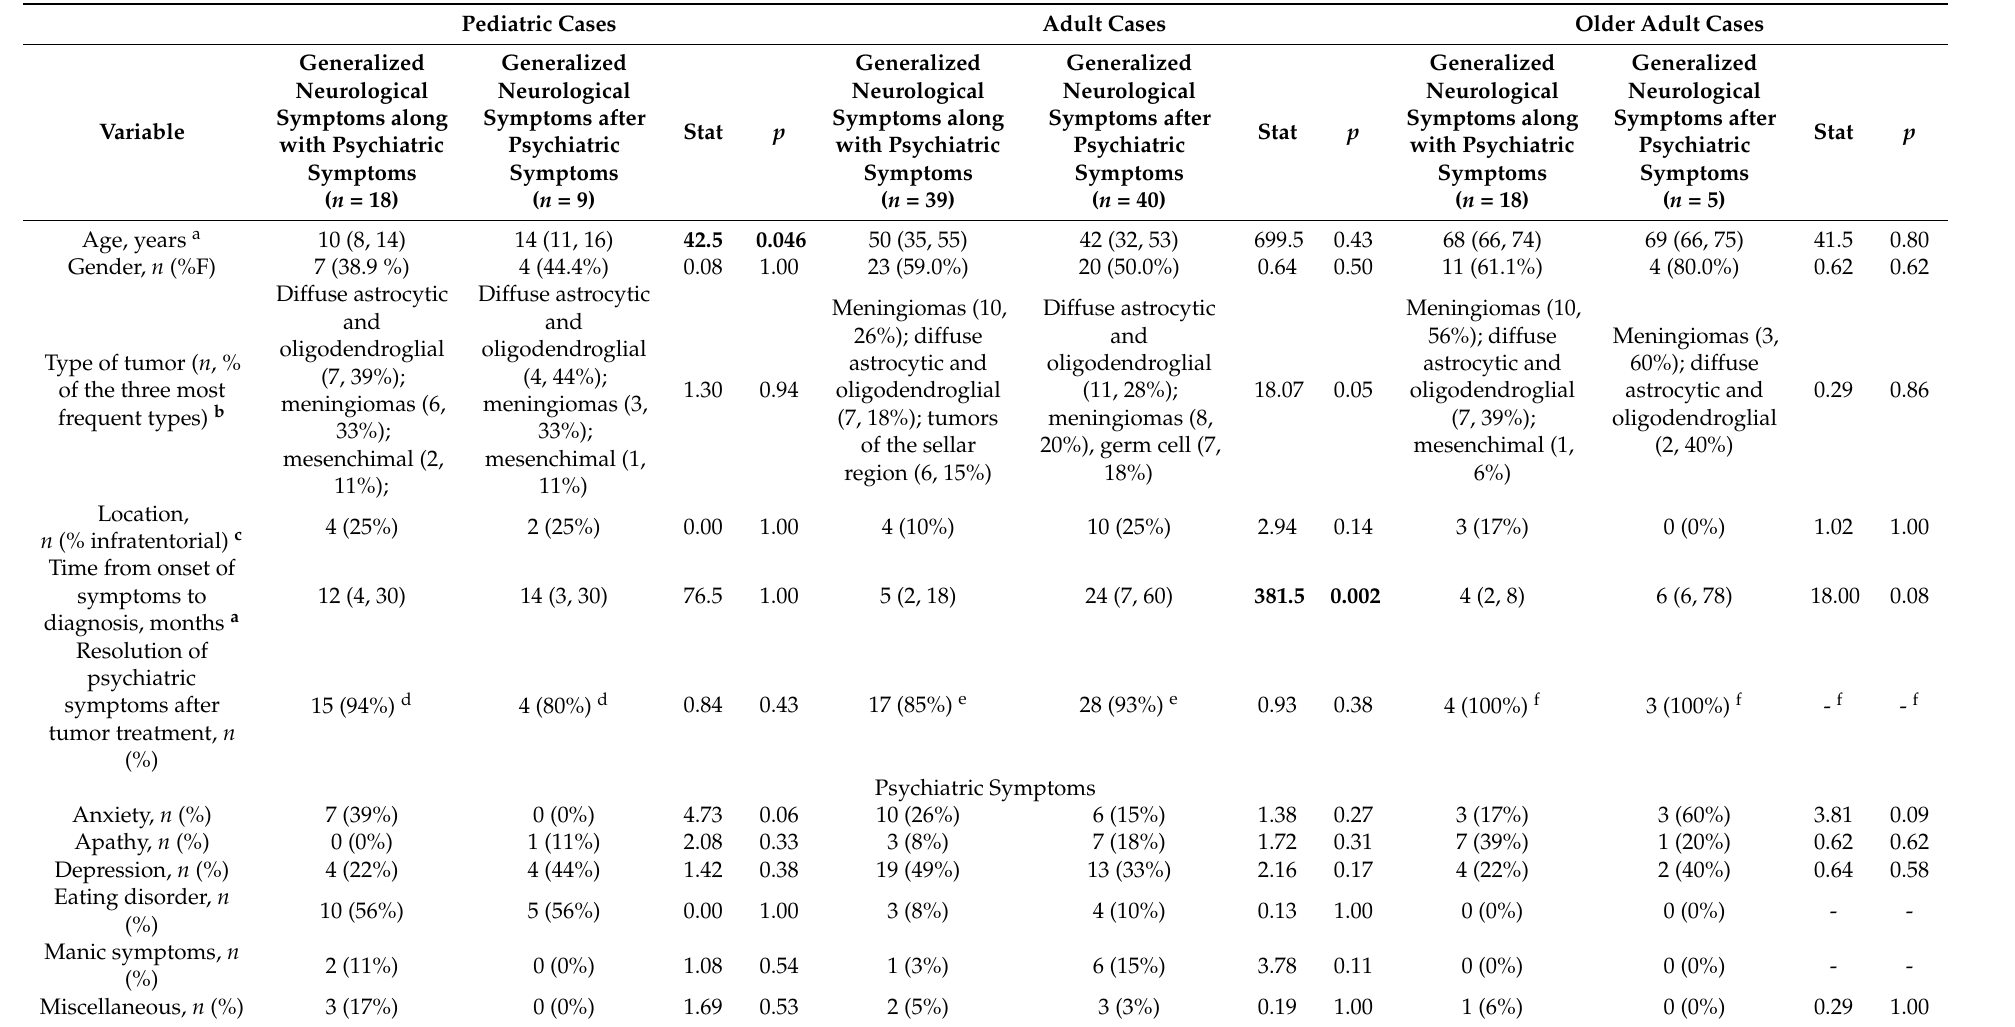
Table 2. Characteristics of cases in which generalized neurological symptoms appeared along with or after psychiatric